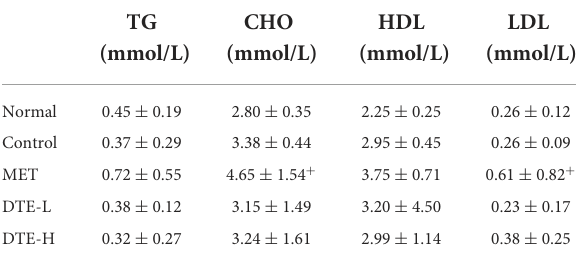
TABLE 1 The effect of DTEon blood lipid levels.